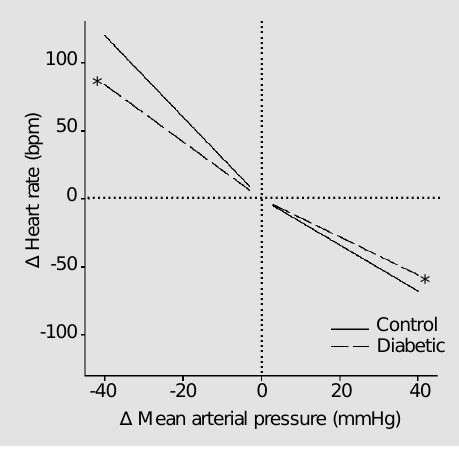
Figure 1. Average linear regres- sion calculated between phenyl- ephrine or sodium nitroprusside changes in arterial pressure and reflex heart rate in control (N = 11) and diabetic (N = 11) rats.